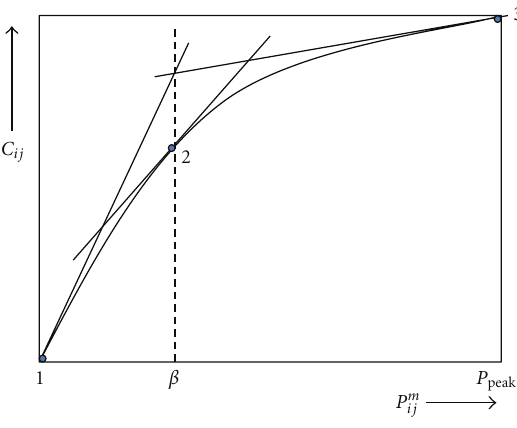
Figure 2: Approximating the log